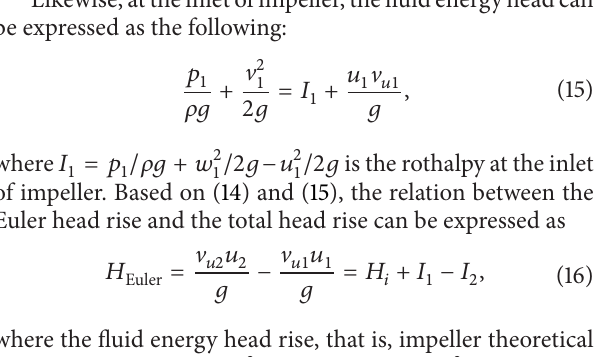
hydraulic losses in the impeller at all, suggesting 𝐼 1 = 𝐼 2 and = 𝐻 𝐻 𝑖 ; for a viscous fluid flow, however, Euler > 𝐻 𝐻 𝑖 . Euler